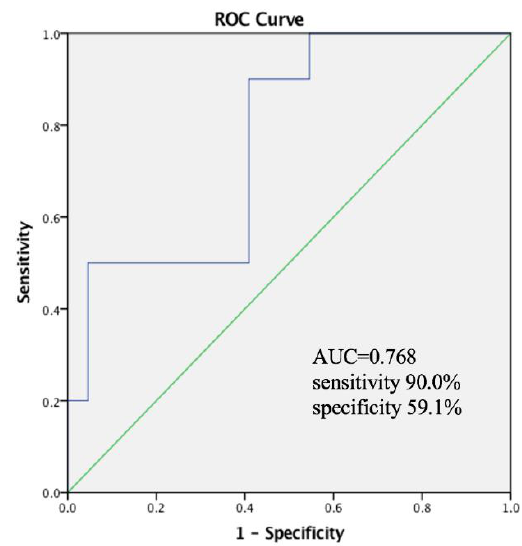
Figure 6. Receiver-operating curve analysis for phase angle (PhA) to distinguish moderate/severe malnutrition in woman according to the GLIM criteria with optimal PhA level cut-off of 5.12°. Table 4. Comparison of patient characteristics, body composition, and clinical data between mod- erate malnutrition and severe malnutrition in CD.